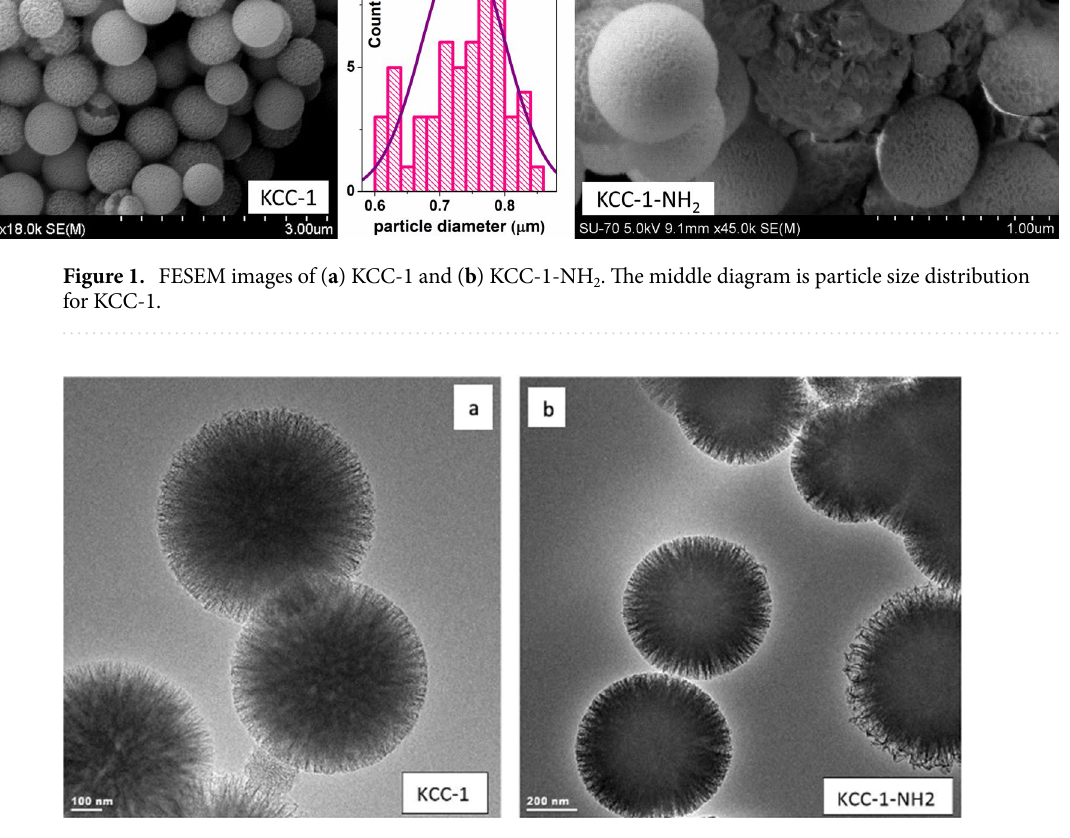
Figure 2. TEM images of ( a ) KCC-1 and ( b ) KCC-1-NH 2